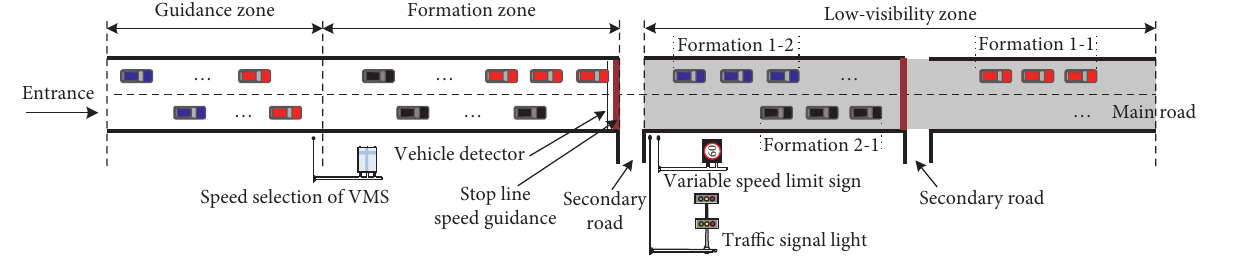
Figure 1: Control